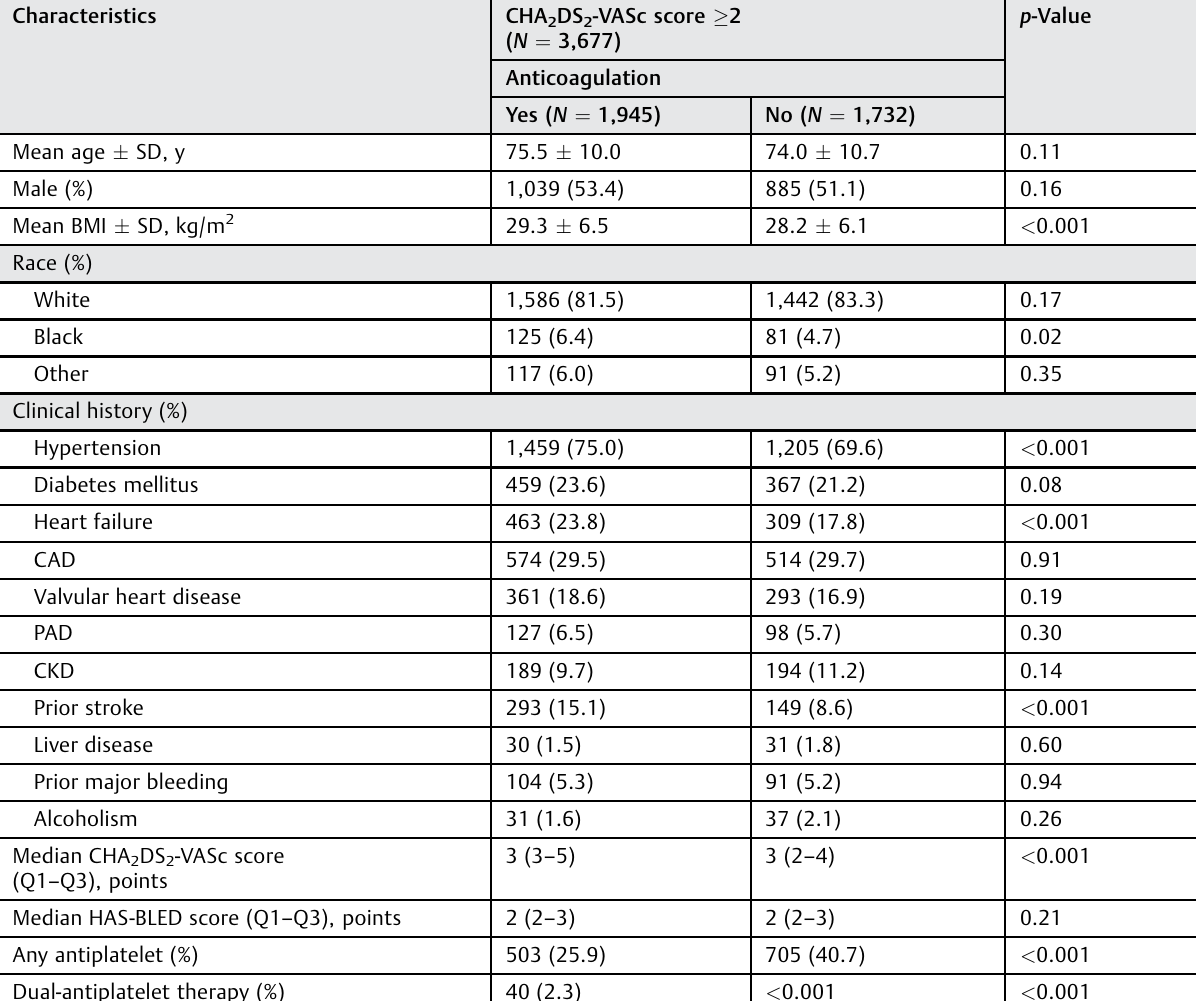
Table 1 Baseline characteristics and antiplatelet regimen of atrial fi brillation patients at risk of stroke as categorized by the 2011 American College of Cardiology/American Heart Association/Heart Rhythm Society (CHA 2 DS 2 -VASc score (cid:1) 2) guidelines, strati fi ed by prescription and nonprescription of